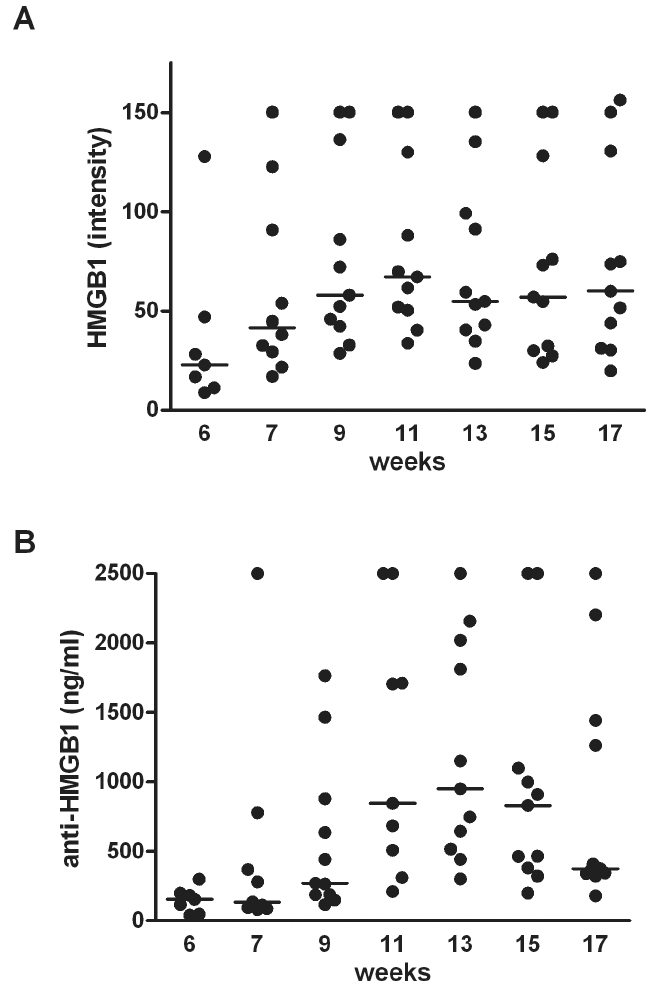
Figure 1. Plasma HMGB1 and anti-HMGB1 antibody levels increase with age in MRL/lpr mice. (A) Plasma HMGB1 levels were measured by Western blot at wks 6, 7, 9, 11, 13, 15 and 17 in MRL/lpr mice (n = 11). HMGB1 levels are presented as values of fluorescence intensity and were normalized against a standard of Jurkat cell lysate. (B) Plasma anti-HMGB levels (ng/mL) were measured by ELISA at wks 6, 7, 9, 11, 13, 15 and 17 in MRL/lpr mice (n = 11). Anti-HMGB1 levels are presented as values of fluorescence intensity and were normalized against a standard of monoclonal anti-HMGB1